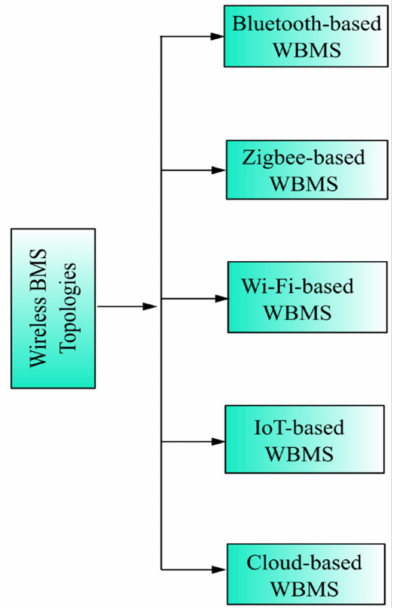
Figure 2. Classification of WBMS